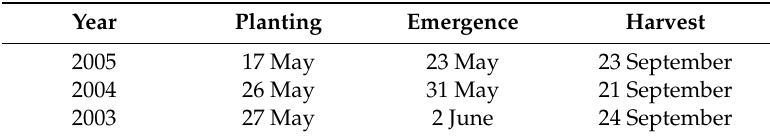
Table 1. Sorghum planting, emergence, and harvesting dates.